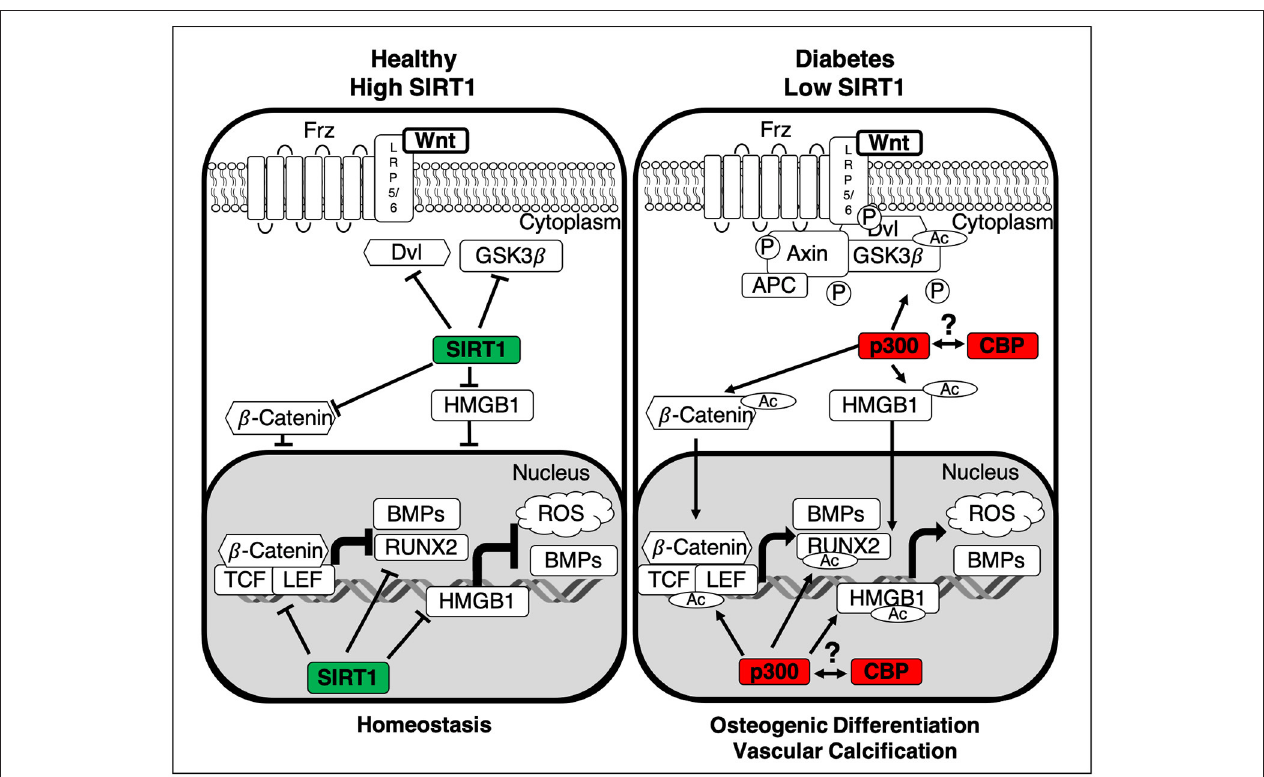
FIGURE 2 | Summary of the interactions between SIRT1 and the canonical Wnt pathway. In healthy homeostatic conditions SIRT1 binds to p300, diminishing its ability to acetylate the β -Catenin complex, comprised of Dvl, GSK3 β and β -Catenin. Additionally, SIRT1 deacetylates both β -Catenin and HMGB1 thus inhibiting their translocation to the nucleus, inactivating Wnt signaling and stopping the development of vascular calcification. In the absence of SIRT1 the β -Catenin complex is activated by p300-mediated acetylation and GSK3 β -catalyzed phosphorylation, inhibiting its ability to degrade β -Catenin. Additionally, HMGB1 and β -Catenin are also acetylated via p300, facilitating their translocation to the nucleus. Subsequently β -Catenin binds cofactors TCF/LEF and following their acetylation transcription of osteogenic factors Runx2 and BMPs is induced. Whilst the epigenetic roles of CBP and p300 are distinct, the role of CBP still remains an area for further investigation. LRP5/6, Low-density lipoprotein Receptor-related Protein 5/6; APC, Adenomatous Polyposis Coli; GSK3 β , Glycogen Synthase Kinase-3 beta; Dvl, Dishelved Protein; TCF/LEF, T-Cell Factor/Lymphoid enhancer factor; Runx2, Runt-Related Transcription Factor; BMPs, Bone Morphogenic Proteins; HMGB1, High Mobility Group Box 1; ROS, Reactive Oxygen Species; Ac, Acetylation; P,